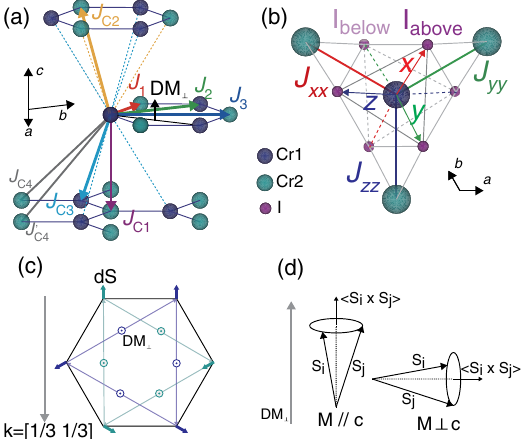
FIG. 1. Crystal structure of CrI 3 . (a) CrI 3 rhombohedral lattice showing only Cr atoms, with Cr 3 þ spins along the c axis. Cr1 (blue) and Cr2 (cyan) spheres indicate Cr atoms in different triangular sublattices. The colored bonds indicate in-plane and interlayer magnetic exchange interactions. The cyan and yellow dashed lines show the three J c 2 ’ s and six J c 3 ’ s around one Cr atom. (b) Kitaev interaction in the local coordinates of CrI 3 . The J J J x; y; z g direction xx , yy , zz bond is between the NNs, and the f is parallel to the Cr-I bond, as shown with arrows. (c) DM interactions in CrI 3 with a top view of the Cr 3 þ hexagon at the Dirac wave vector. The cyan and blue colors distinguish two triangular sublattices. (d) Interactions between DM and spins. Only when spins have components along the c axis can the DM term give a nonzero contribution to the total